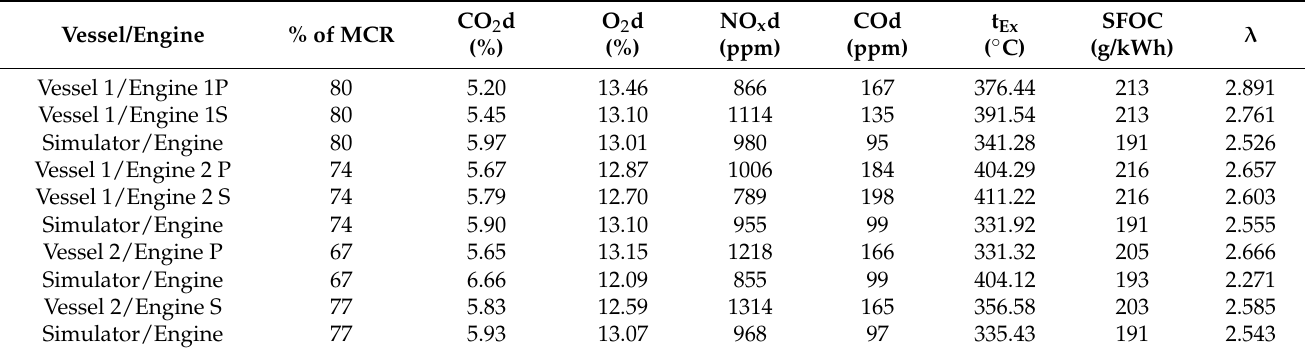
Table 4. Comparison of exhaust gas measurements and engine operating parameters from Vessel 1, Vessel 2 and simulated Ro-Pax